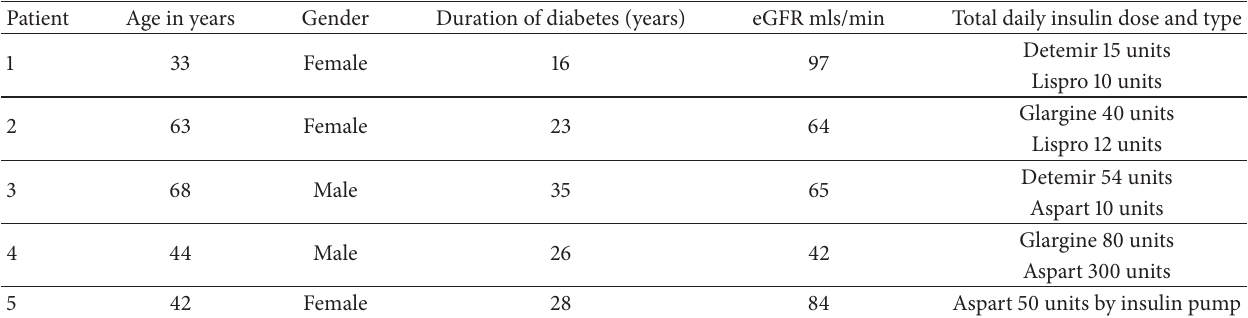
Table 1: Characteristics of type 1 diabetic patients before SGLT2 therapy.